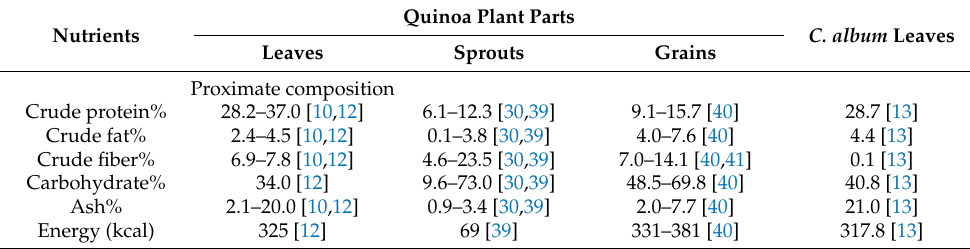
Table 2. Nutritional composition of quinoa plant parts and C. album leaves. Numbers in parenthesis refer to citations from which the nutrients data for quinoa plant parts and C. album were obtained.